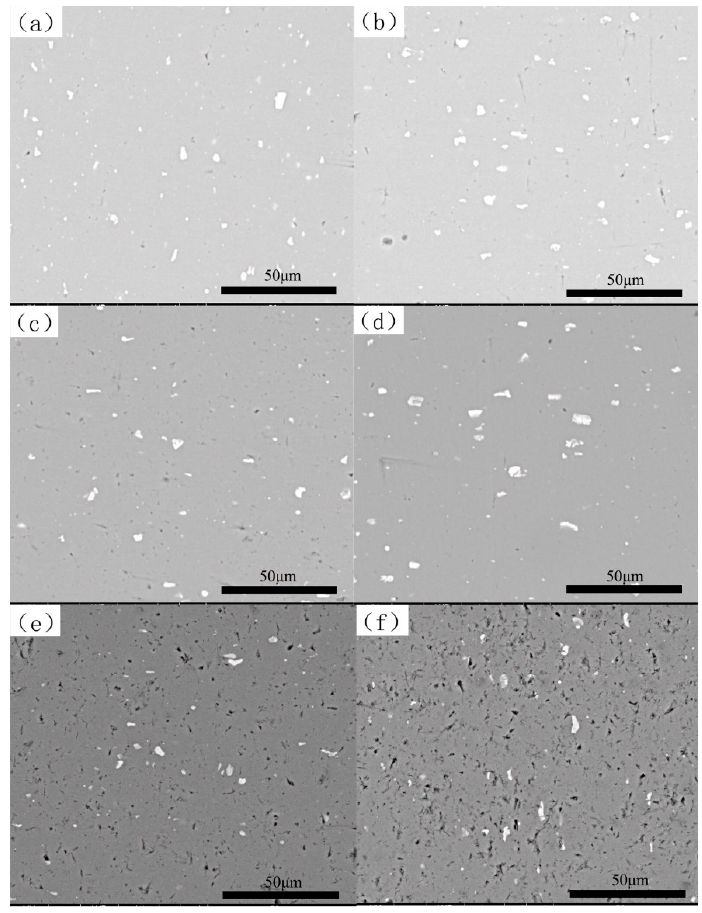
Figure 5. SEM micrographs of AA specimens. ( a ) 4 h; ( b ) 8 h; ( c ) 14 h; ( d ) 24 h; ( e ) 72 h; ( f ) 96 h.